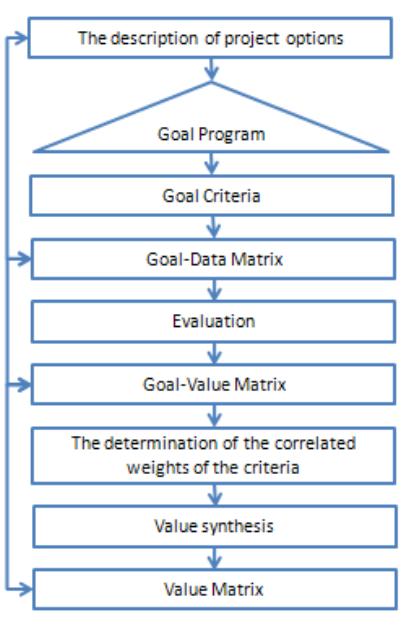
Figure 4. Flow sheet of